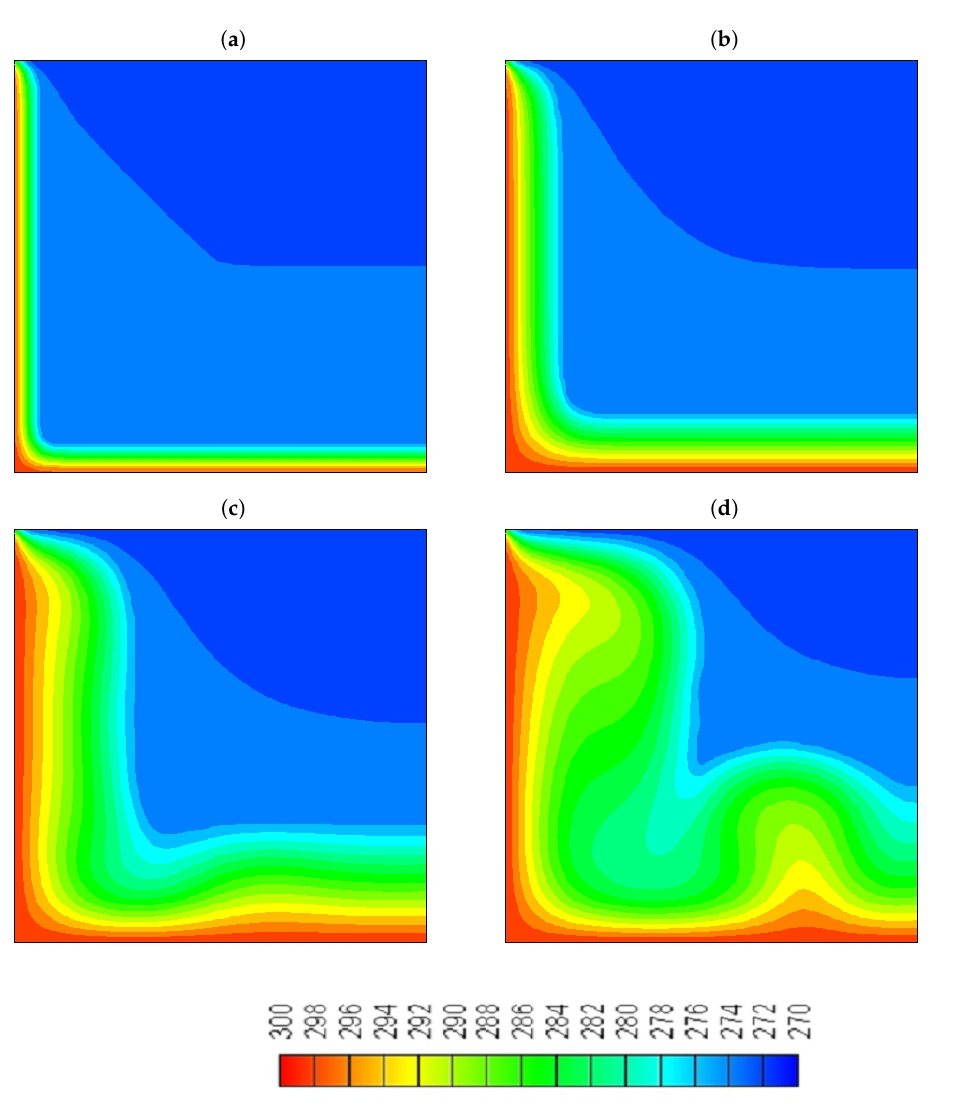
Figure 3. The evolution of temperature profiles for the case of pure water φ w = 0. ( a ) t = 2 s, ( b ) t = 6 s, ( c ) t = 25 s, ( d ) t = 50